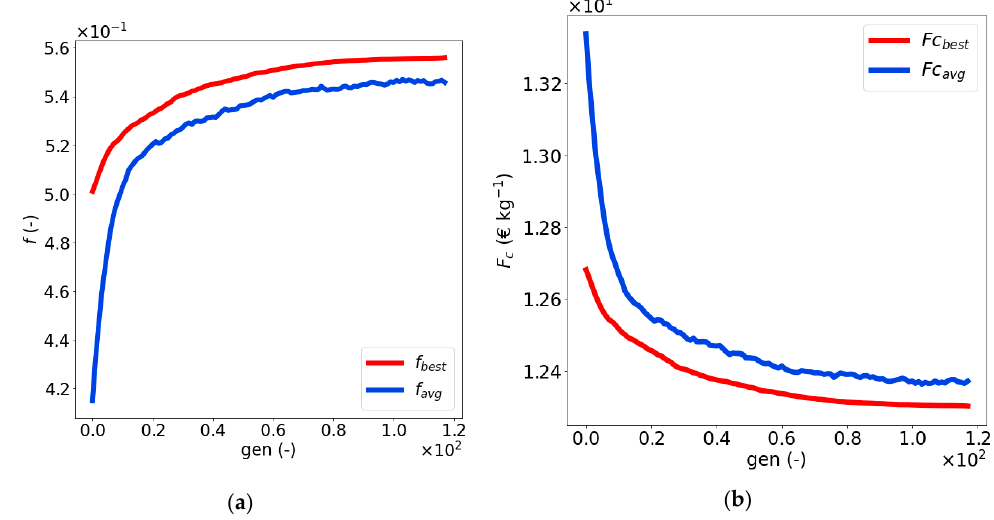
Figure 16. Averaged over 100 evolutions ( a ) Fitness and ( b ) cost function evolution according to the generation with k gen = 118, k pop = 17, p m = 0.5% ( IC s = 14,000 € m − 2 , EC = 0.17 € kWh − 1 , b an = b cath = 0.15 V dec − 1